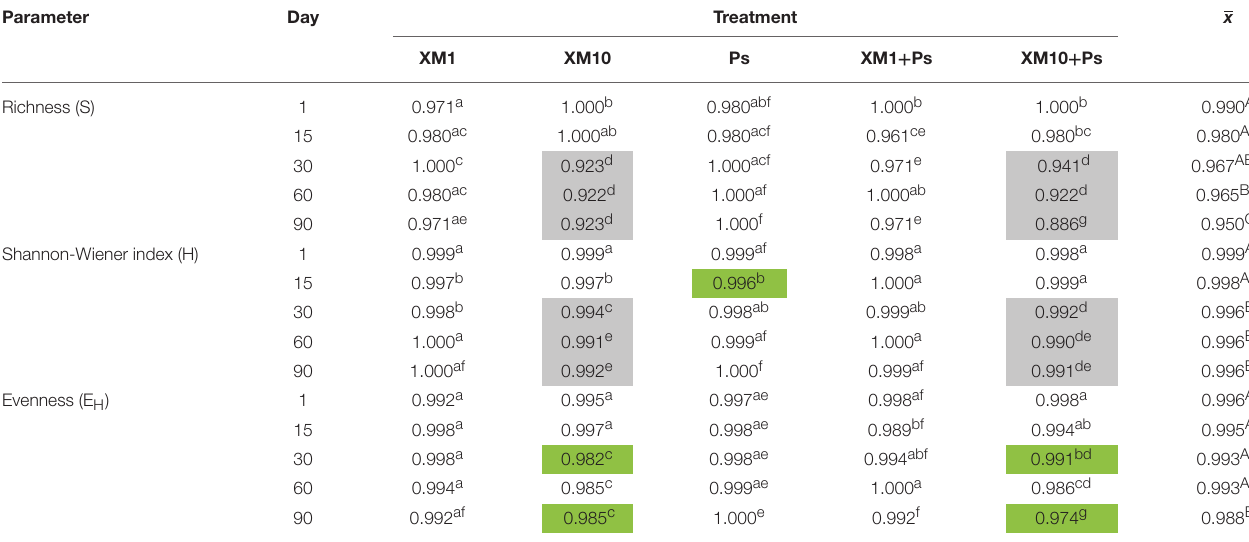
TABLE 3 | Values of the resistance (RS) index for measured parameters obtained for each day of the experiment. Parameter Day